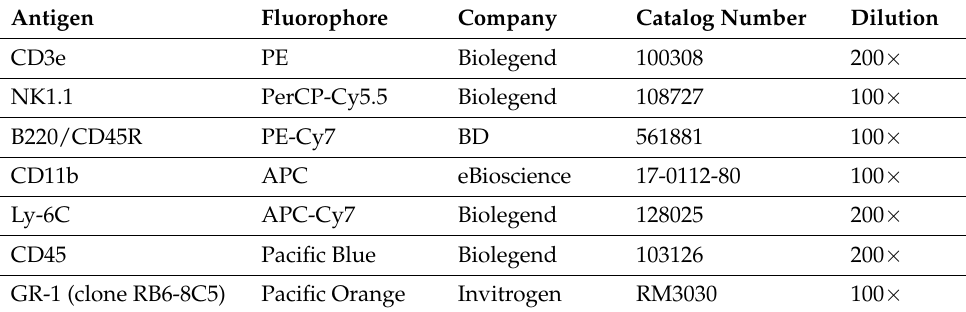
Table 3. Antibodies used to detect other leukocytes.